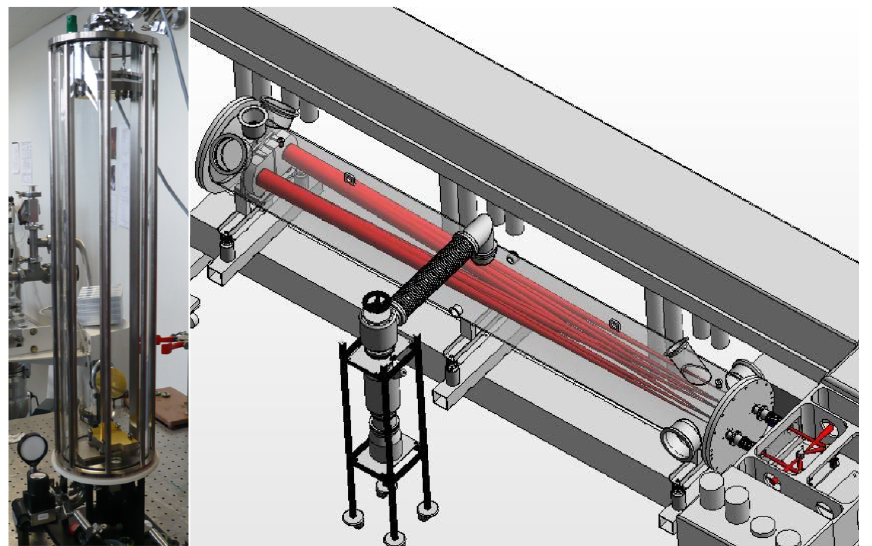
Figure 1. Picture/Scheme of the two White-type gas cells used for the CH 4 rotational spectra measurements. Left: standard White-type cell (Infrared Analysis, 35-V) used in the cw-THz pho- tomixing measurement [14]. Right: White-type cell located in the AILES beamline of the SOLEIL synchrotron